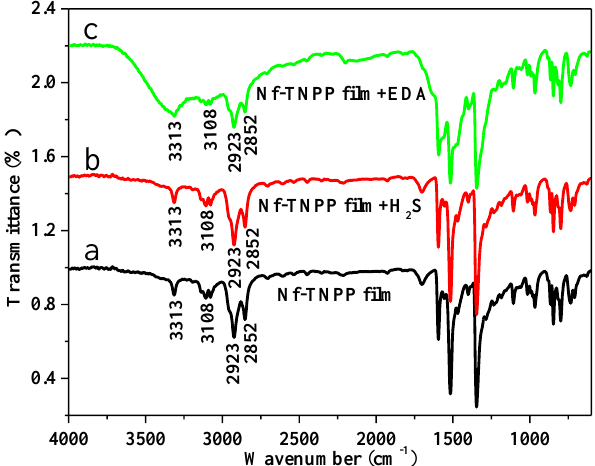
Figure 5. FT-IR spectra of the Nf-TNPP thin film (a) before, and after exposure to (b) H 2 S and (c) EDA vapor.